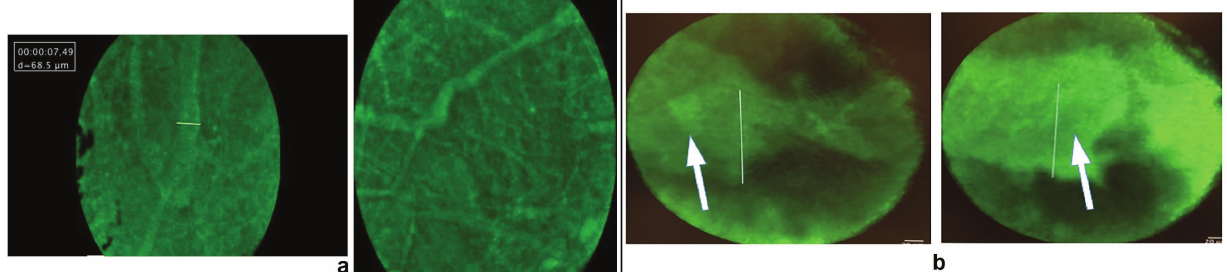
Figure 4. Visualization of episcleral vessels (a) and Schlemm’s canal (b) with minimal tissue manipulation. Episcleral vessels are seen emanating from deeper, larger-caliber vascular structures. The white bar represents a length of 50 𝜇 m. Visualization of Schlemm’s canal (white arrow) is only possible after a scleral flap is introduced because the microendoscope is limited to a depth of 100 micron in scleral tissue. The white bar in (b) represents a length of 120 𝜇